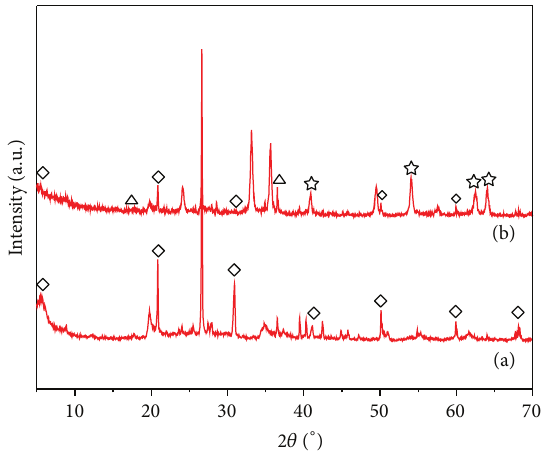
Figure 1: XRD patterns of (a) bentonite, (b) TiO 2 -Fe 3 O 4 -bentonite. ⬦ Bentonite; 󳵻 Fe 3 O 4 ; f TiO 2 (rutile).